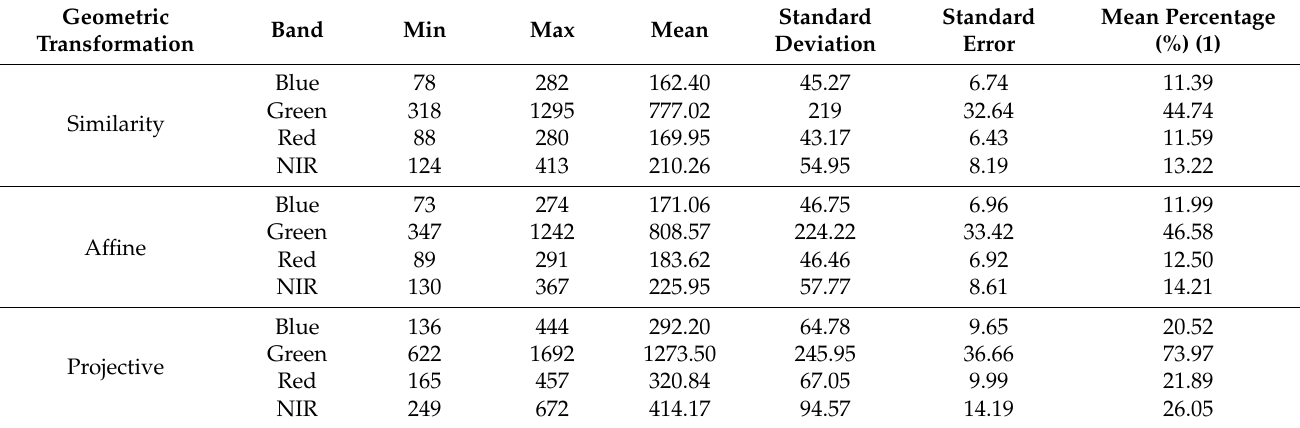
Table 6. Descriptive statistics as a function of the band for the number of inliers matching points obtained using the SURF features and three geometric transformations over the blue, green, red, and NIR band images (moving images) and the red-edge band images (fixed image) in the case of 45 multispectral images acquired with the MicaSense ® RedEdge camera. Geometric Band Max Mean Transformation